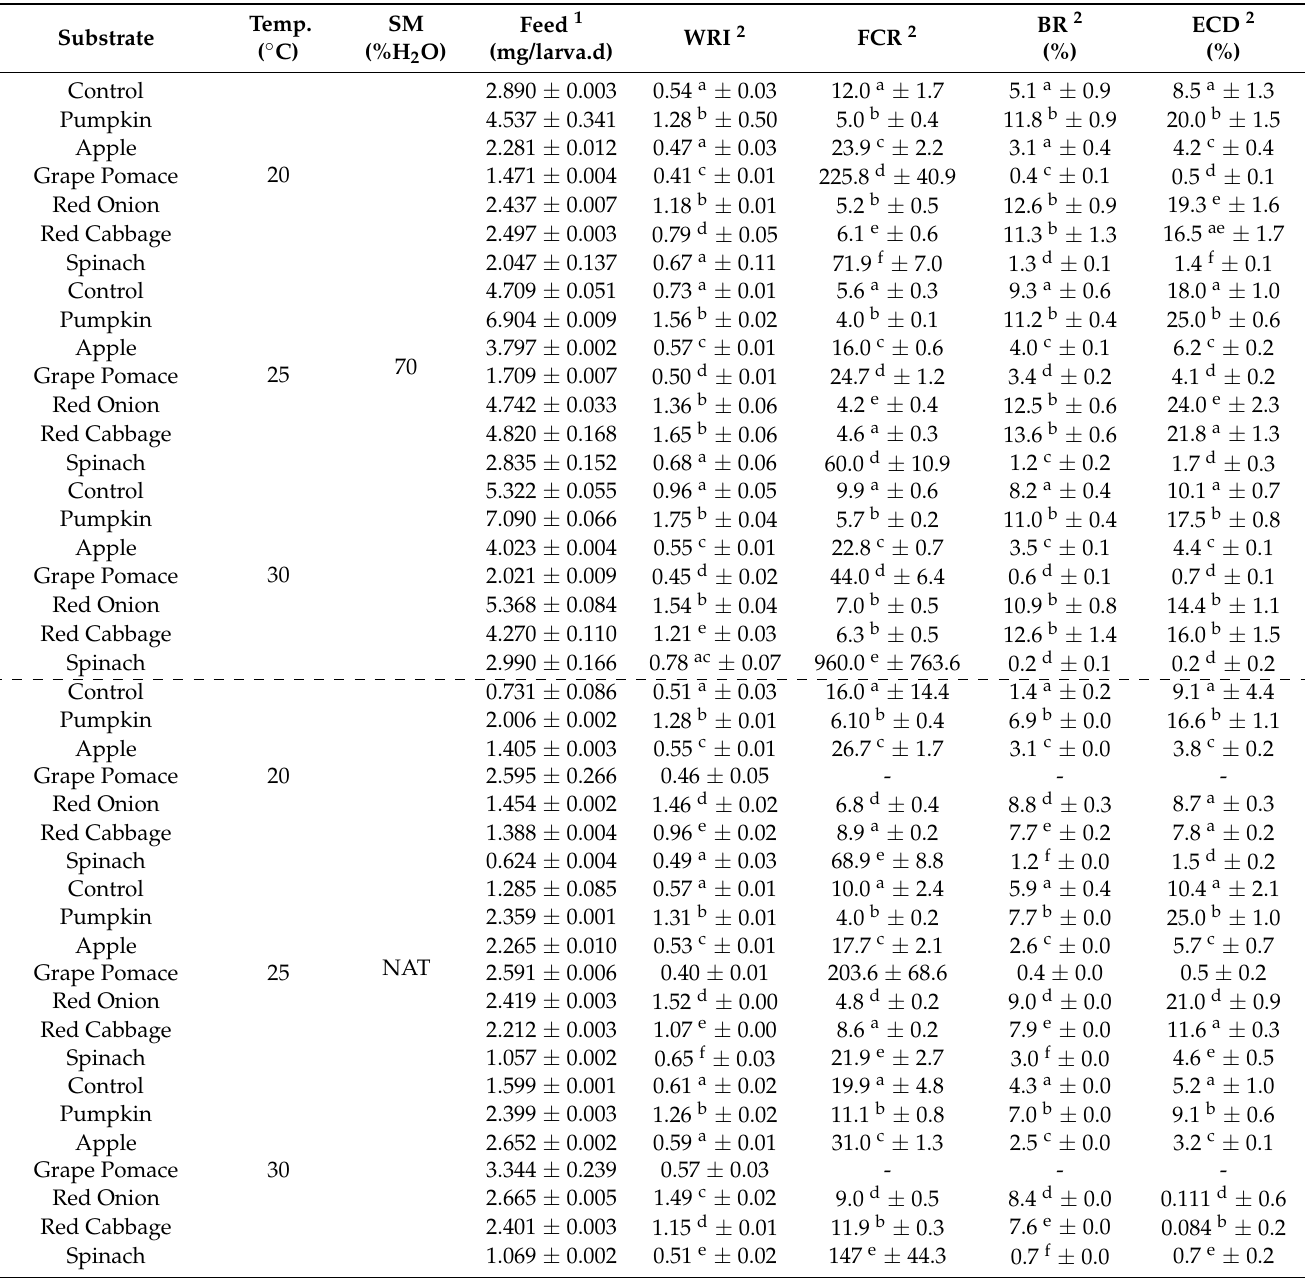
Table 3. Comparison of black soldier fly conversion parameters (mean ± SD) fed with the tested substrates under different tested conditions (temperature and moisture); WRI—waste reduction index (dry matter); FCR—feed conversion ratio; BR—bioconversion ratio; ECD—efficiency of conversion of digested